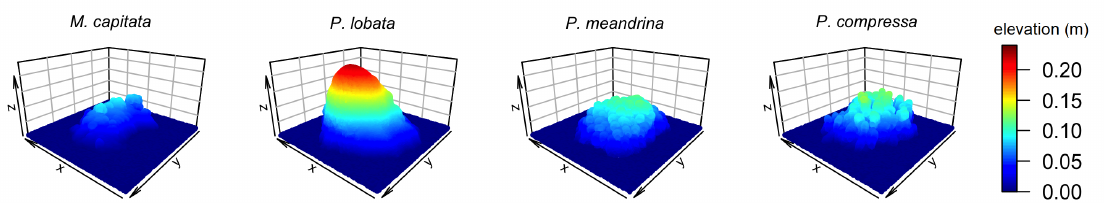
Figure 2. Three-dimensional visualization of four coral colonies with different morphologies: encrusting M. capitata , mounding P. lobata , branching P. meandrina and branching P. compressa .